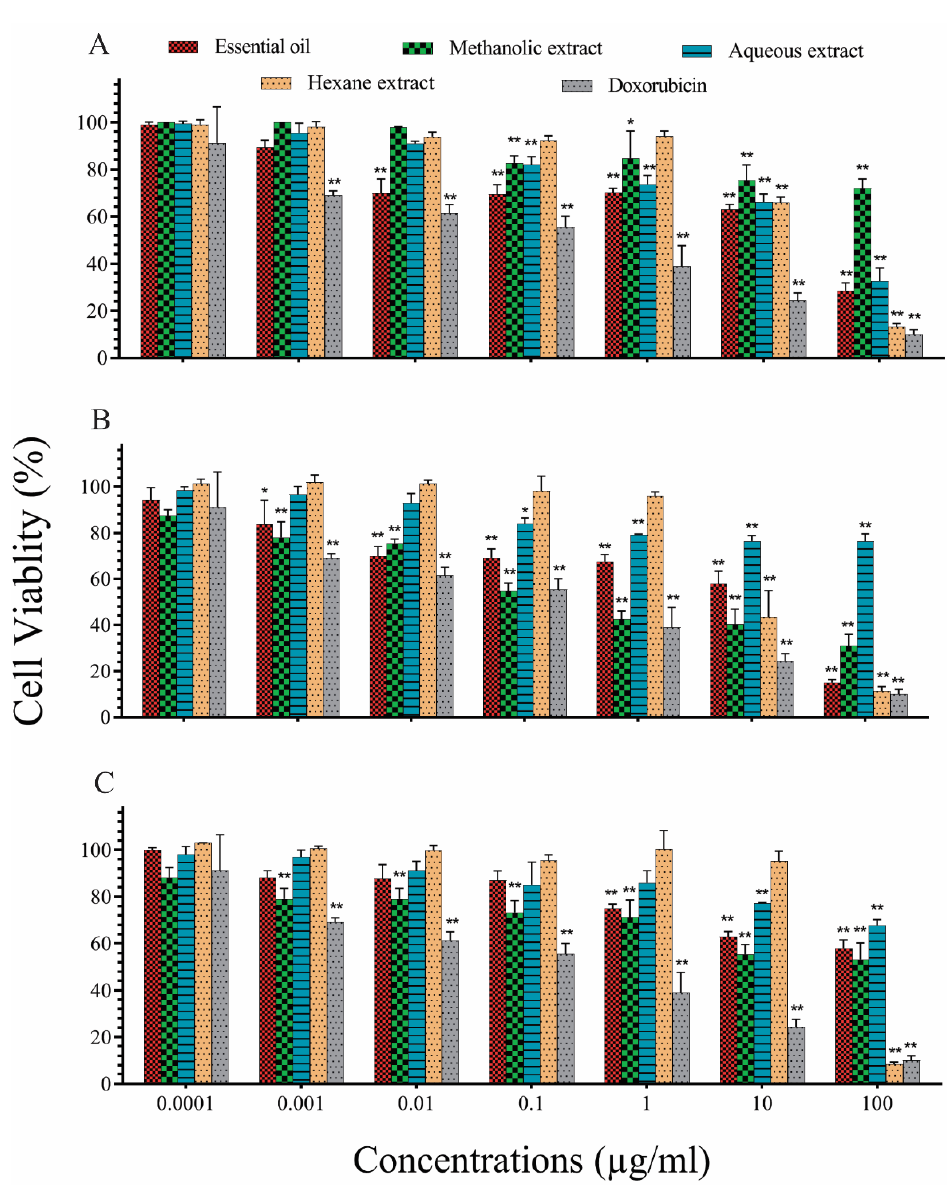
Figure 2. Cytotoxic activity of the four different fractions (hexane, methanolic, aqueous extracts, and essential oils) prepared from Pinus eldarica ( A : Bark, B : Needles, and C : Pollen) against the A549 cell essential oils) prepared from Pinus eldarica (A: Bark, B: Needles, and C: Pollen) against the A549 cell line after 48 h of treatment with various concentrations of essential oil, and methanolic, aqueous, and hexane extracts. Data are expressed as mean ± standard deviation (SD), representative of three independent experiments. * p < 0.05 and ** p < 0.01 vs.